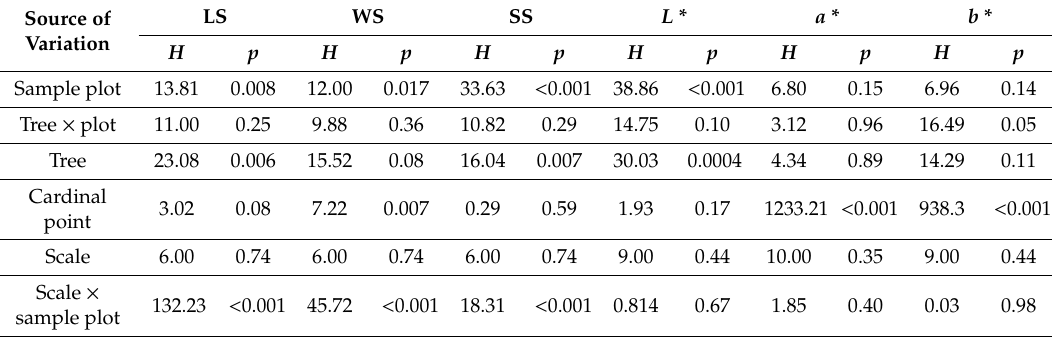
Table 3. The statistical significance of the influence of some factors on the analyzed bark features, using the Kruskal-Wallis